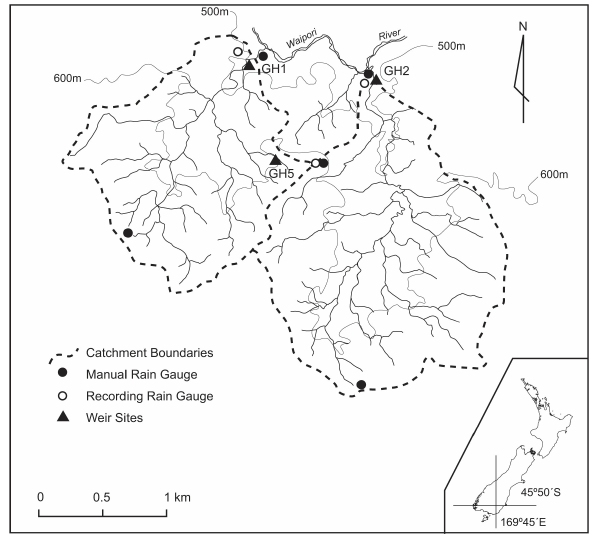
Fig. 1. 2 Fig. 1. Map of Glendhu catchments (GH1, GH2 and GH5).